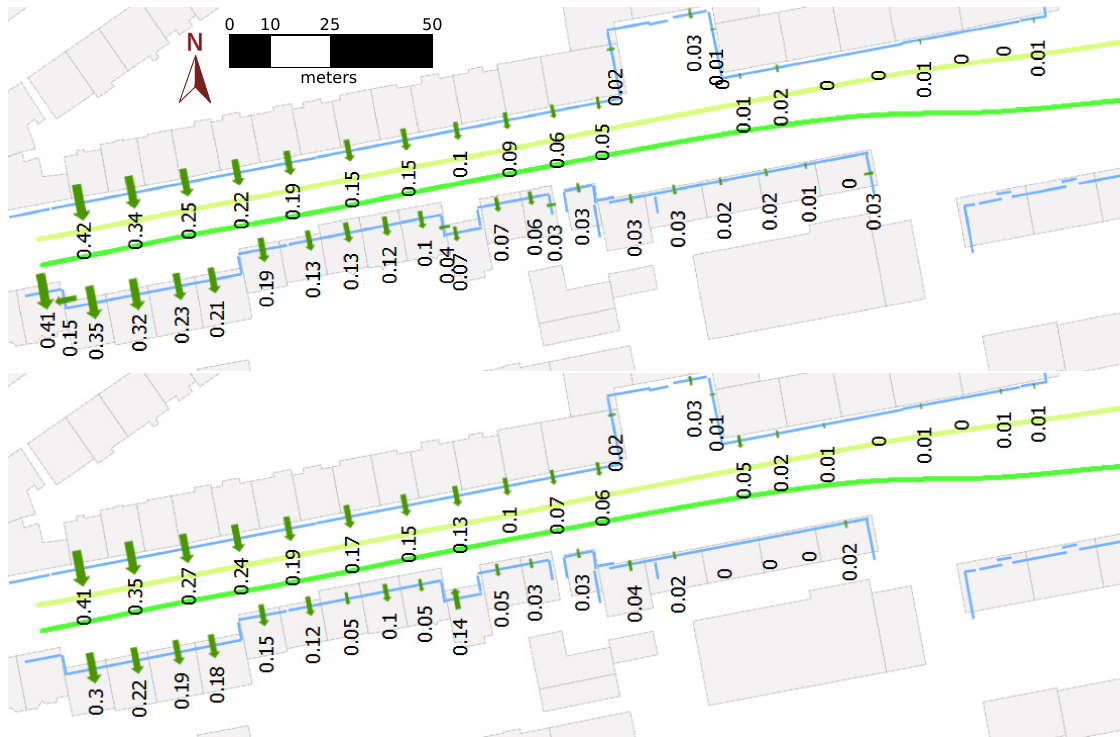
Figure 17. Facade errors with current state-of-the-art techniques in the Dortmund 2 dataset. From top to bottom: left sensor in the first pass compared to the left sensor in the second pass; left sensor in the first pass compared to the right sensor in the second pass; right sensor in the first pass compared to the left sensor in the second pass; right sensor in the first pass compared to the right sensor in the second